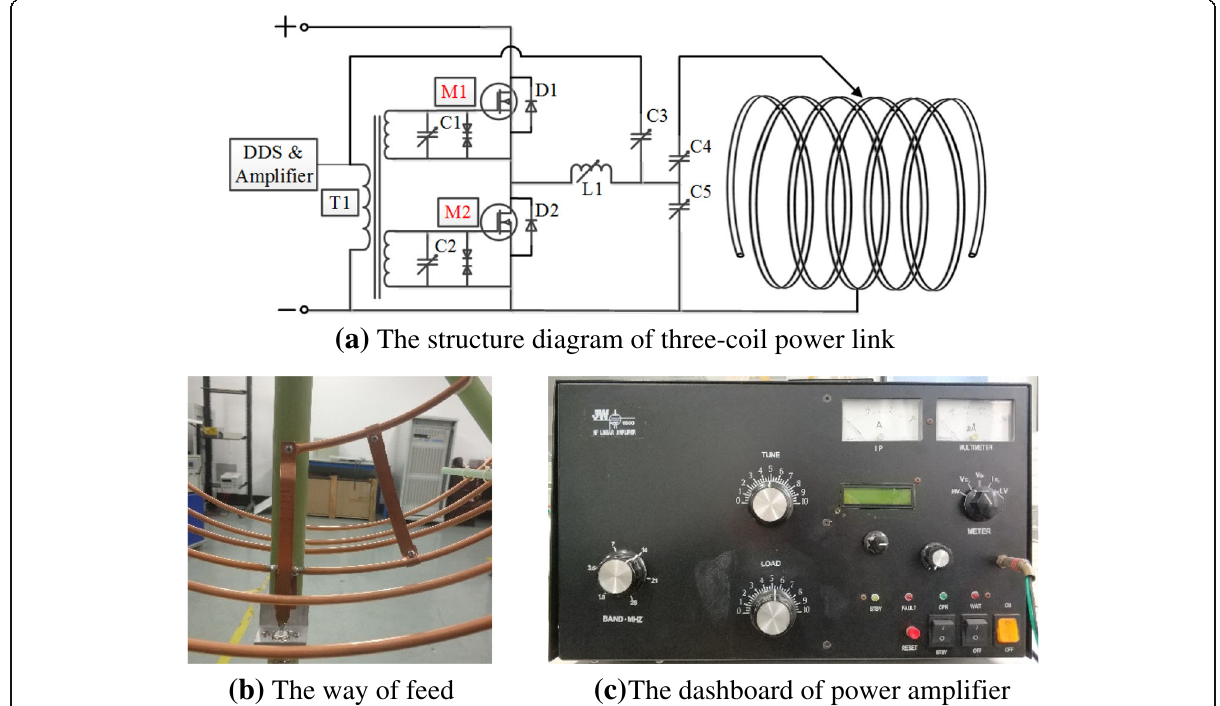
Fig. 1 Structure diagram of three-coil power link and experimental system. a The working principle of the three-coil wireless charging system. The waveform is generated through the DDS circuit. After multilevel amplification, the power is loaded onto the resonant coil. b The way of power loading, which improves the power conversion efficiency by the way of central feeding. The power supply prototype used in the experiment is shown in c . a The structure diagram of three-coil power link. b The way of feed. c The dashboard of power